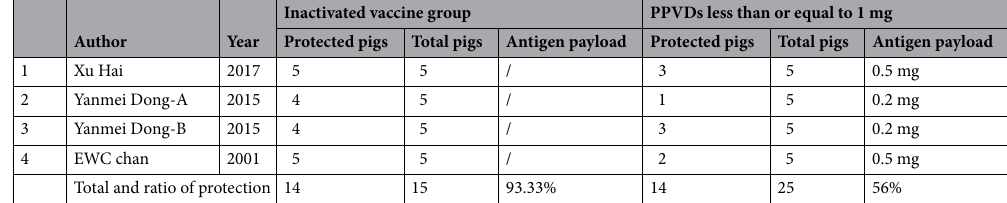
Table 5. Number of animals protected by PPVDs less than or equal to 1 mg group and the inactivated vaccine